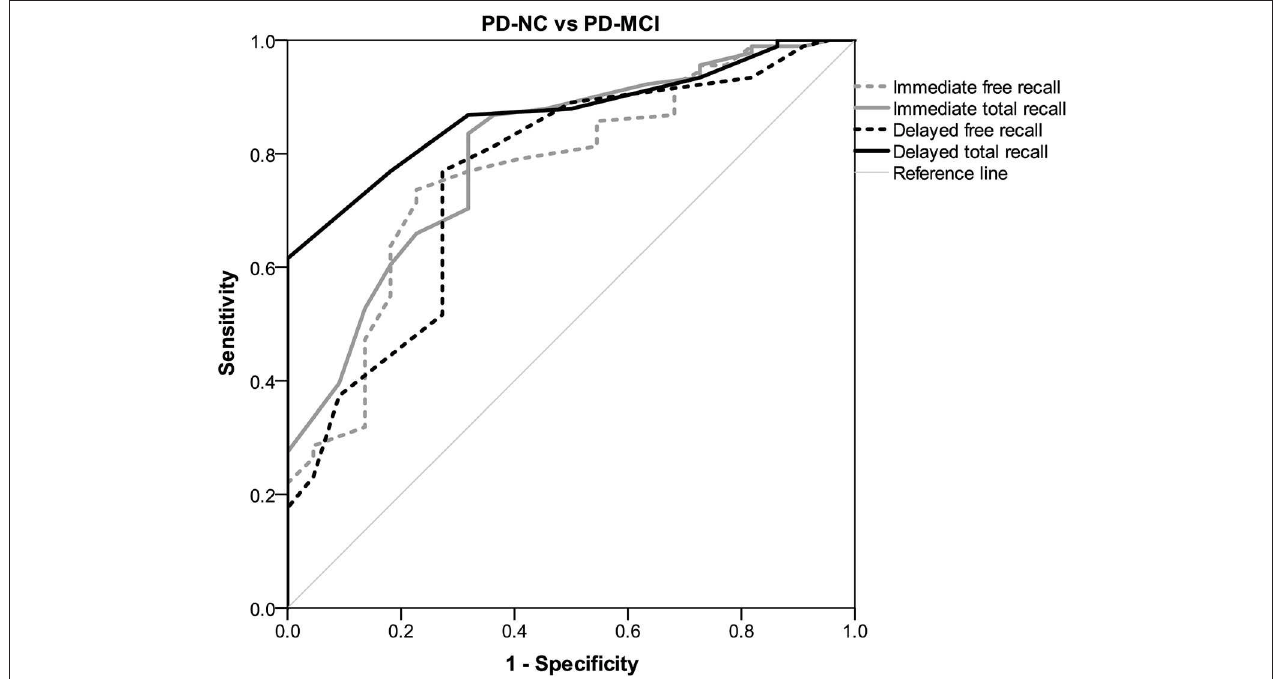
FIGURE 1 | Receiver operating characteristic (ROC) curves illustrating the discriminative properties of the FCSRT.